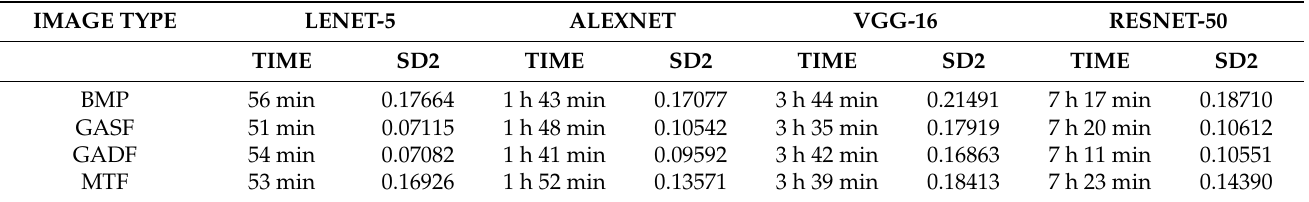
Table 2. The network model inference time (TIME) and loss curve standard deviation (SD2) for the four different types of images with four different neural